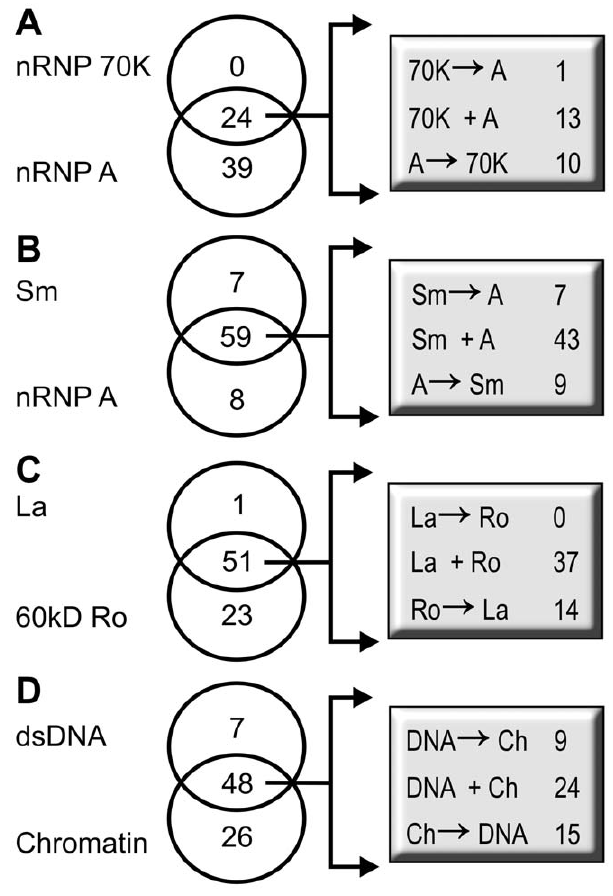
Figure 3. The order of onset of protein-specific autoantibodies within the linked systems. Antibodies to nRNP A commonly appeared prior to anti-70 K (A) while a variable onset was seen between Sm and nRNP A (B). Anti-60 kD antibodies virtually always precede anti-La antibodies (C). The order of appearance did not favor anti-dsDNA or anti-chromatin when compared to each other